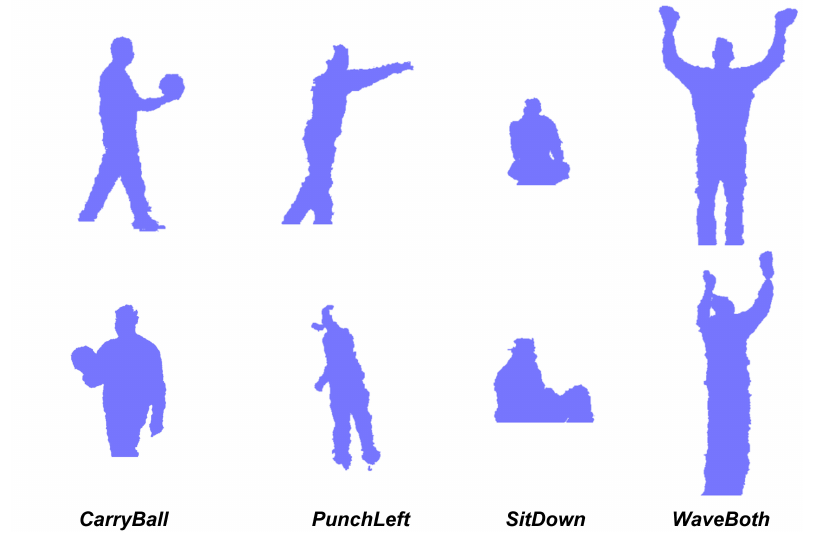
Figure 8. Sample silhouettes from our RGB-D dataset: front view at the top and backside view at the bottom.